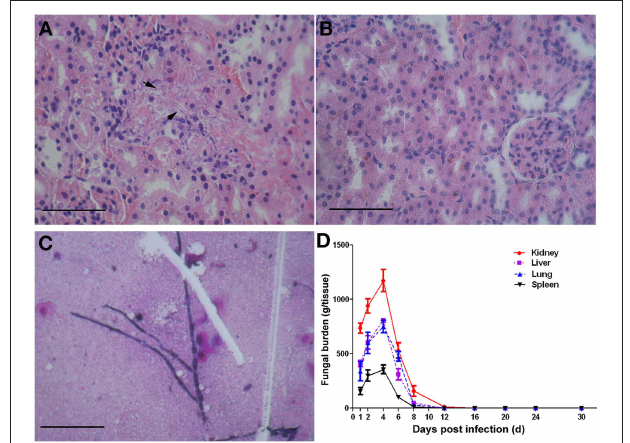
FIGURE 2 | The murine model of systemic candidiasis. Mice were injected i.p. with a dose of 1 × 10 6 CFU of C. albicans SC5314 or sterile saline as control. On the day of 0, 1, 2, 4, 6, 8, 12, 16, 20, 24, and 30 post infections, three mice of each group were randomly chosen and sampled. Disease progression was measured in terms of vital organ burdens and kidney histopathology. Fungal cells (arrowheads) are obvious in the kidneys of mice infected with C. albicans SC5314 (A) , and control kidneys showed no evidence of fungal cells or immune cell infiltrates (B) . Fungal hyphae can be observed in peritoneal fluid of infected mice (C) . Scale bar represents 100mm. The vital organ fungal burdens reached their peak on the 4th day and ceased to exist on the 12th day post infection (D)